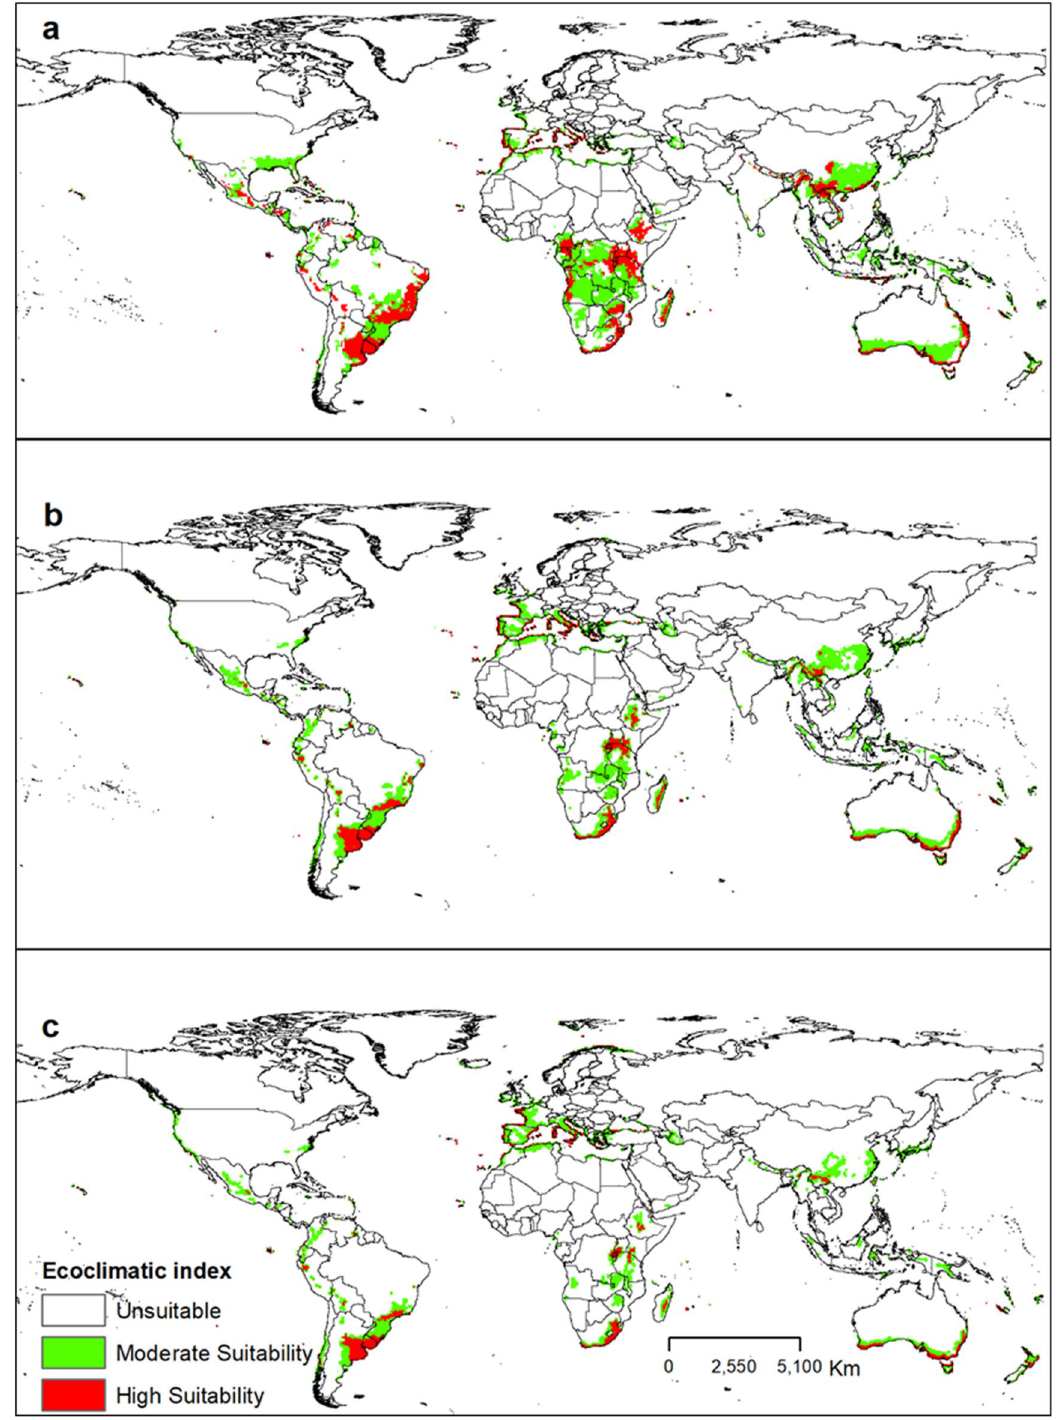
Figure 5. The Ecoclimatic Index (EI) for Trioza erytreae modelled using CLIMEX running the SRES A2 scenario for the current time ( a ), 2050 ( b ) and 2070 ( c ). ESRI ArcMap 10.2.2 (https:// suppo rt. esri. com/ en/ Produ cts/ Deskt op/ arcgis- deskt op/ arcmap/ 10-2- 2# downl oads) and CLIMEX 4.0.0 (https:// www. hearne. softw are/ Softw are/ CLIMEX- DYMEX/ Editi